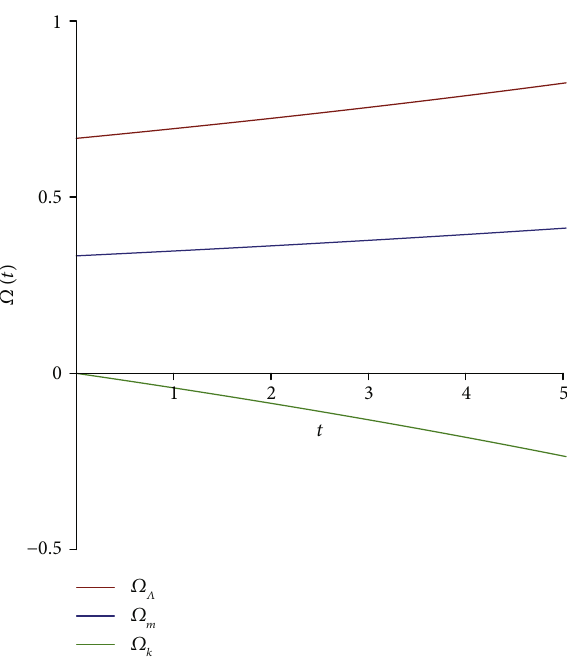
Figure 4: Plot of Ω ð t Þ versus t for k = +1